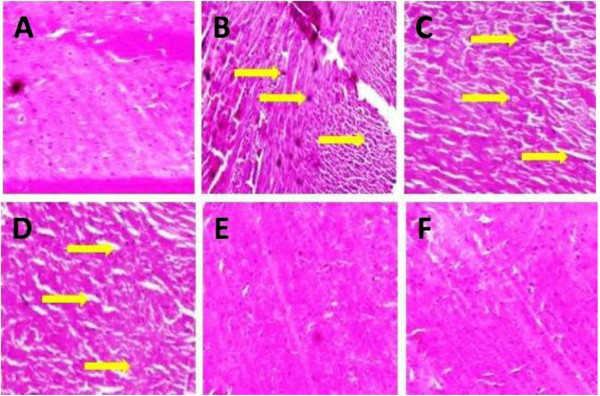
Effect of Melastoma malabathricum Linn. (MM) on heart in different groups of rats: (A) Normal control: Normal control group shown normal histopathology of the heart (B) Diabetic control: Diabetic control histopathology shown increased interstitial space and distort the intercalated disc (yellow arrow) (C) MM I (100 mg/kg): Tested drug histopathology shown decreased interstitial space and intercalated disc (yellow arrow) (D) MM II (250 mg/kg): Tested drug histopathology shown less interstitial space (yellow arrow) (E) MM III (500 mg/kg): Tested drug histopathology shown normal heart like the glibenclamide (F) Glibenclamide (10 mg/kg): Glibenclamide treated drug shown the normal histopathology of heart. The samples were obtained from the same liver anatomical regions. For each group, 6 rats were examined and 50 pictures were taken. The above picture for each group was chosen randomly from the 80 pictures in this group. Original magnification, 10 ×.